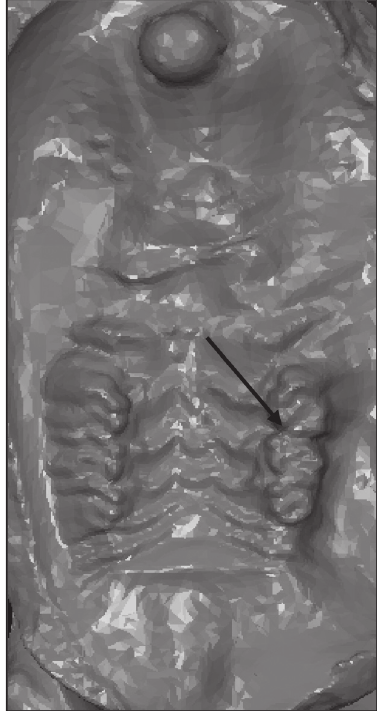
Figure 2: Three-dimensional scan of the cast of a rat that received caffeine simultaneously with orthodontic treatment using ABViewer software. The arrow indicates the amount of